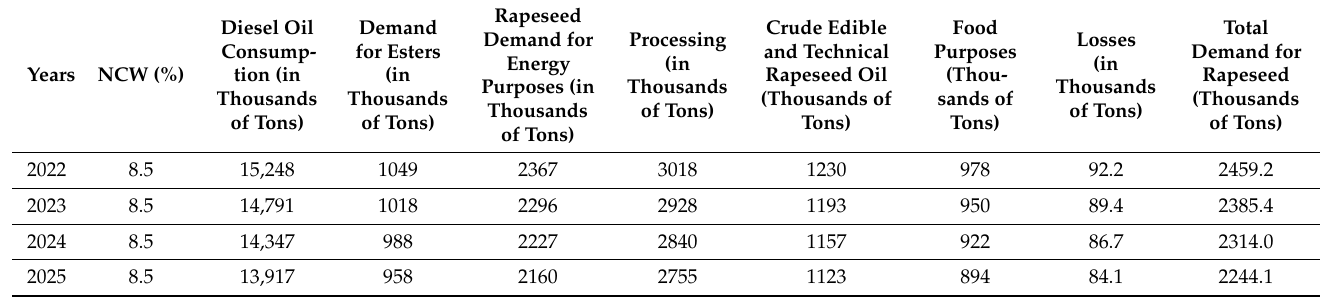
Table 4. Assumptions for the scenario of a 3% decrease in demand for